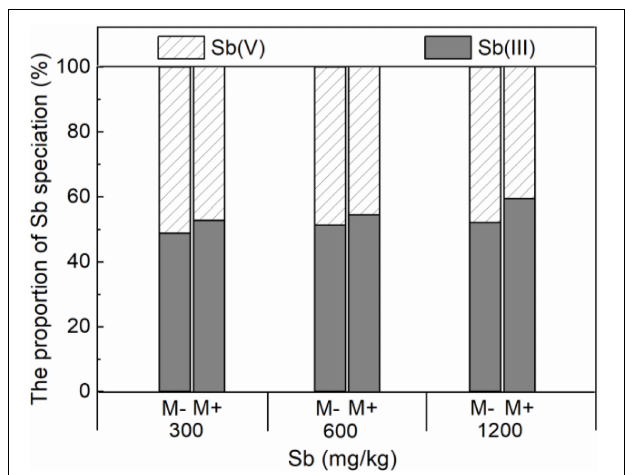
FIGURE 6 | Effects of AMF on the proportion of Sb speciation in roots of